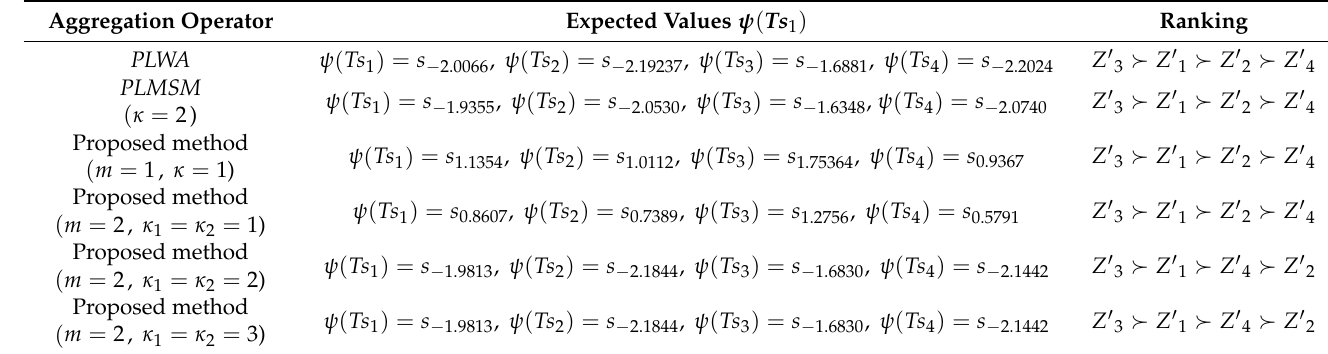
Table 3. A comparison of the ranking results for different MAGDM